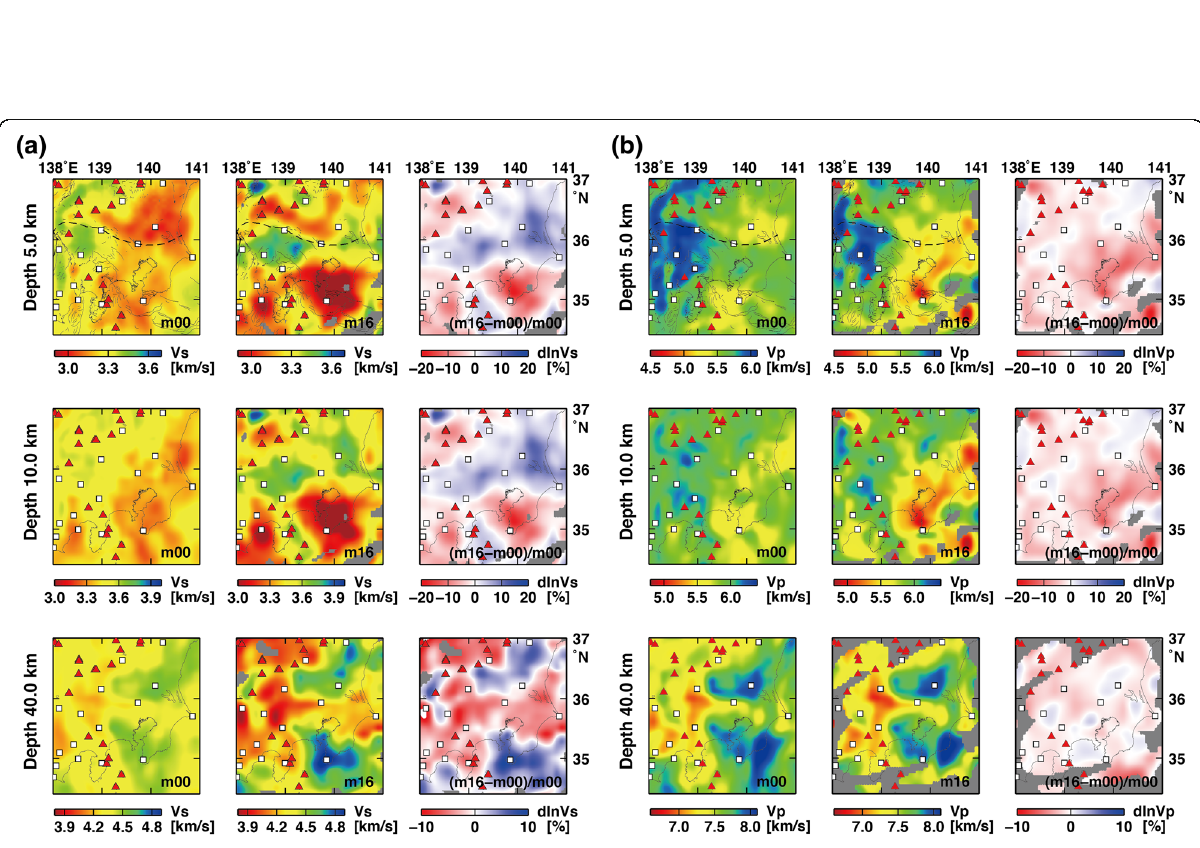
Fig. 11 Depth slices concerning the seismic wave speed model. a V s and b V p models. The left, center, and right panels show the wave speed of m 00 , the wave speed of m 16 , and the difference between the wave speeds of m 00 and m 16 . Open squares and red triangles represent F-net stations and volcanoes, respectively. In ( a ), active faults and the MTL are shown as black lines and a broken line,